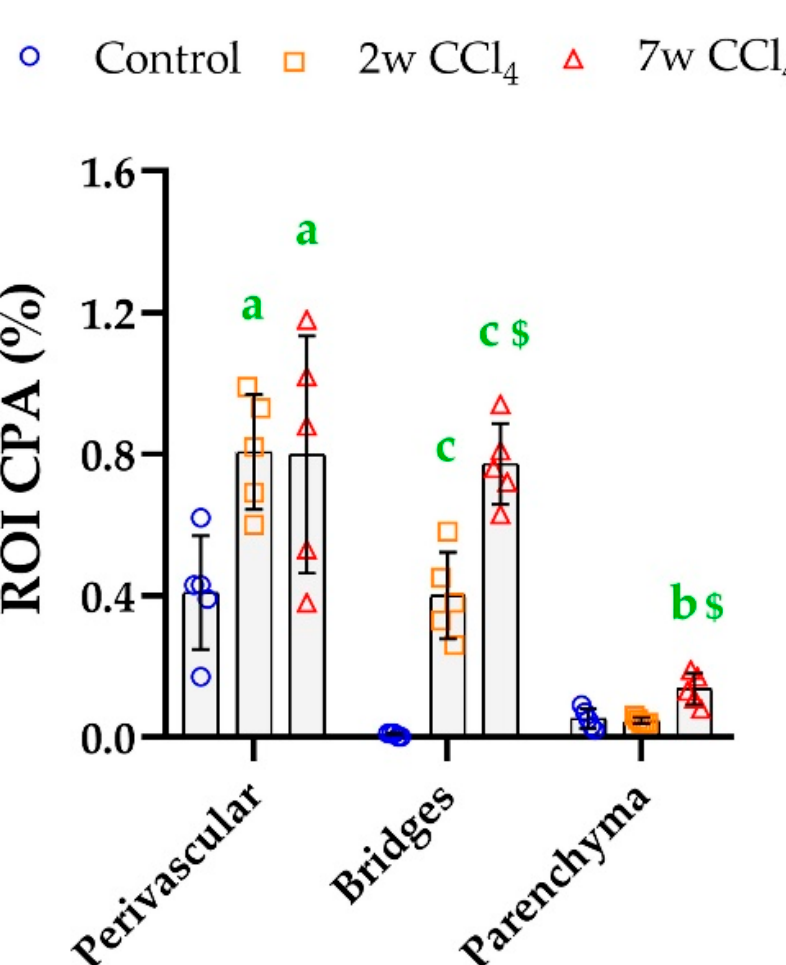
Figure 6. Liver ROI CPA calculated for each ROI using the PSR OPT detection method. Mean ( ± SD) and one-way ANOVA with Fisher’s post-hoc test. a: p < 0.050, b: p < 0.010, c: p < 0.001 vs. controls; $ : p < 0.001 vs. middle group.